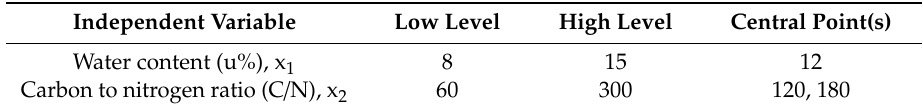
Table 2. Experimental parameters and levels investigated.